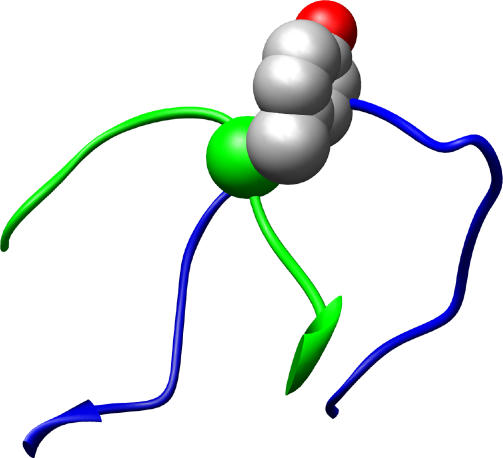
Detailed View of One Portion of the Structural Superposition between the Phosphorylated and Unphosphorylated Crystal Structures of CDK2/Cyclin AThe phosphorylated activation loop (blue) passes through the middle of Tyr179 (CPK) when inserted into the non-phosphorylated structure (green) of CDK2. Figure prepared with Chimera [72].